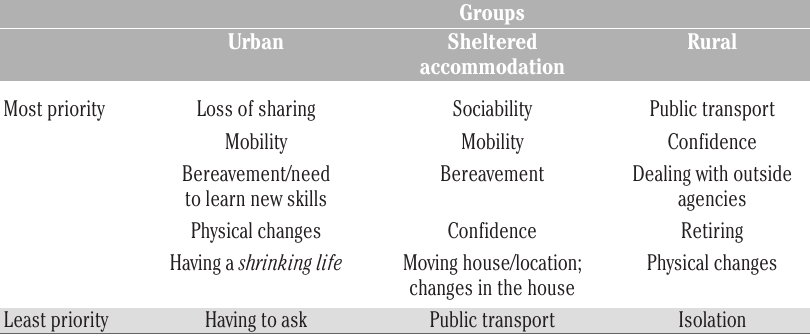
Table 1. Prioritized changes experienced in later